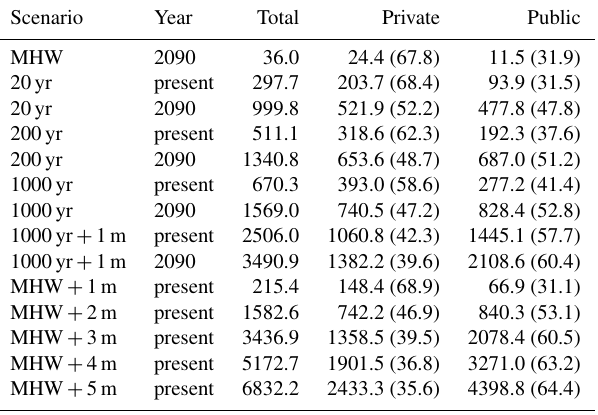
Table 4. Affected roads (km) in Norway under different water lev- els at present and for 2090. Numbers in parentheses indicate the percentage share of the total for each subcategory. Note that the lengths of affected roads for present MHW have been subtracted from the numbers for higher water